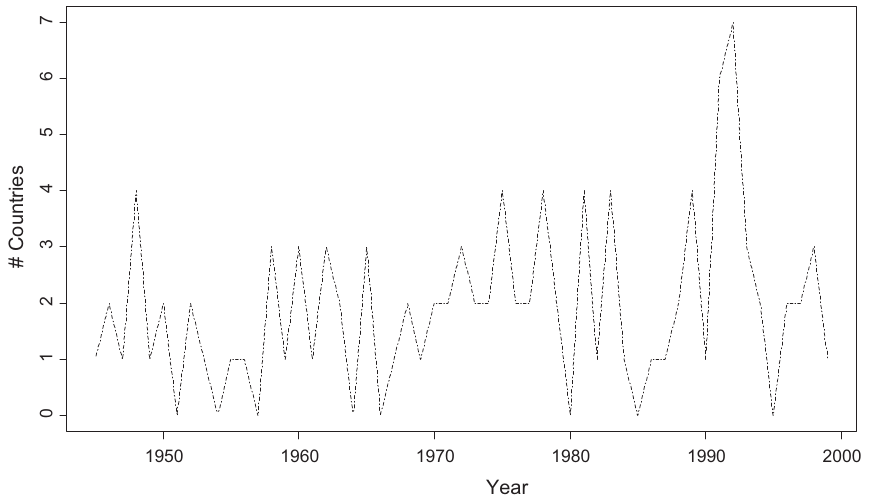
Figure 1. Number of